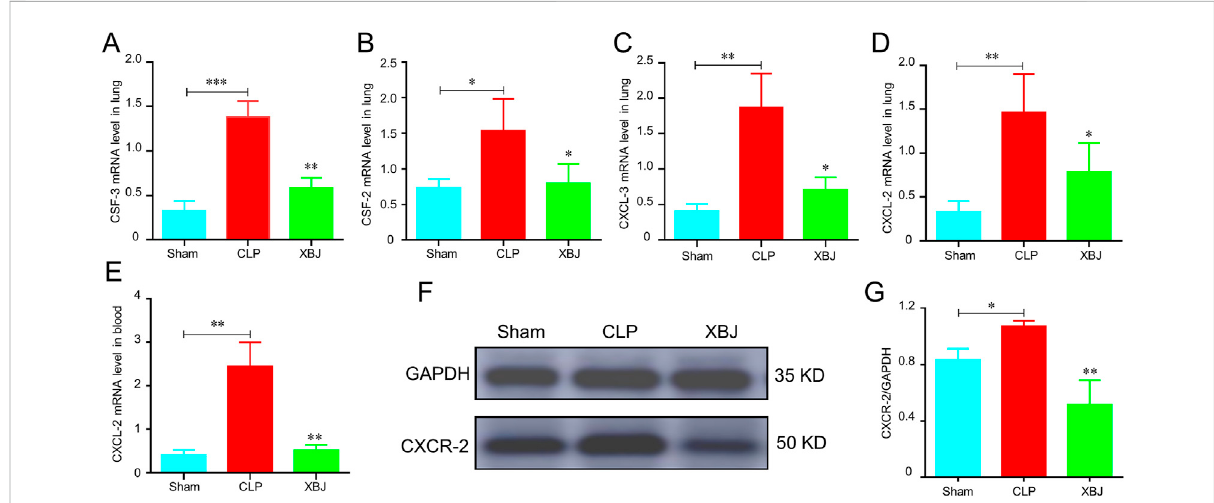
FIGURE 3 XBJreducedthechemokinessecretion insepsis-induced lunginjury. (A – D) .The relativemRNAexpressionlevelsofchemokinesinlungtissues of different groups of mice, including CSF-3 (A) , CSF-2 (B) , CXCL-3 (C) , and CXCL-2 (D) , were determined by real-time PCR (E) . CXCL-2 mRNA expression in the peripheral blood of different groups of mice was determined by real-time PCR. N ≥ 4/per group. F&G. The CXCR-2 protein expression was determined with Western blot, the representative images were shown in (F) and were quanti fi ed in (G) ( n = 3). The values were indicated as mean ± SD. * p < 0.05, ** p < 0.01, compared with the CLP